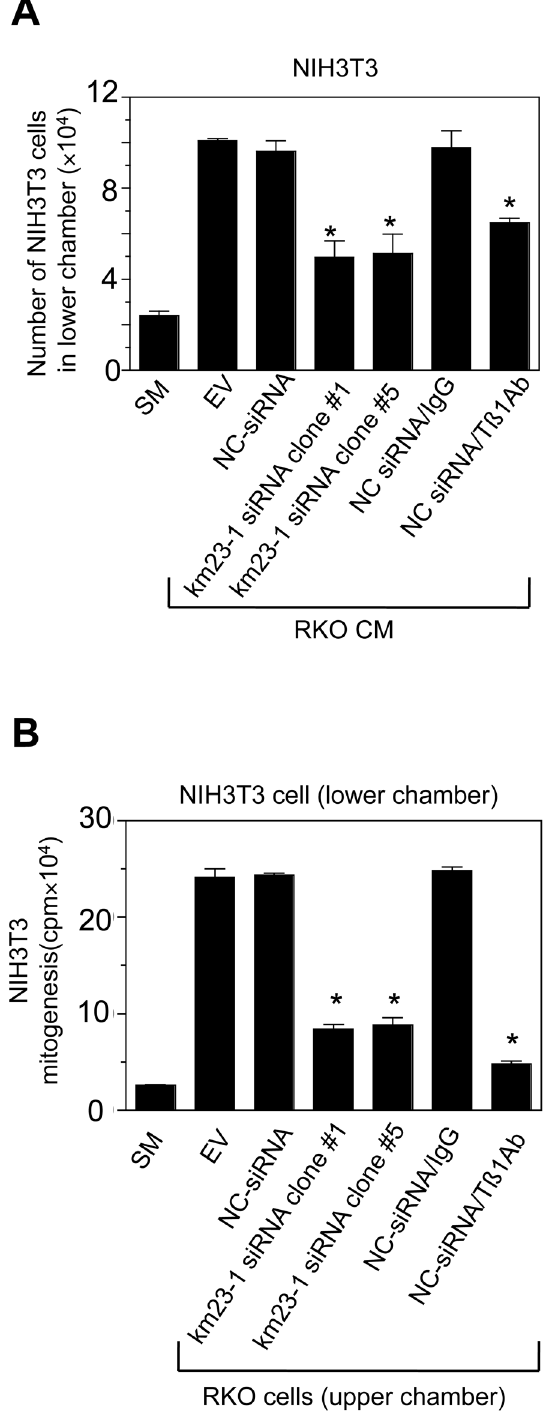
Figure 3. km23-1 regulates the paracrine effects of active TGF b 1 on NIH3T3 cell migration and mitogenesis. A: NIH3T3 fibroblasts were plated onto polycarbonate membrane filter inserts (8.0 m m pore size) in 6-well Transwells and CM from RKO cells and their siRNA stable transfectants were added to the NIH3T3 cells as described in ‘‘Materials and methods.’’ Cells migrating into the lower chambers were counted. SM: supplemented McCoy’s (SM) medium; EV: CM from RKO-EV cells; NC siRNA: CM from NC siRNA-RKO cells;